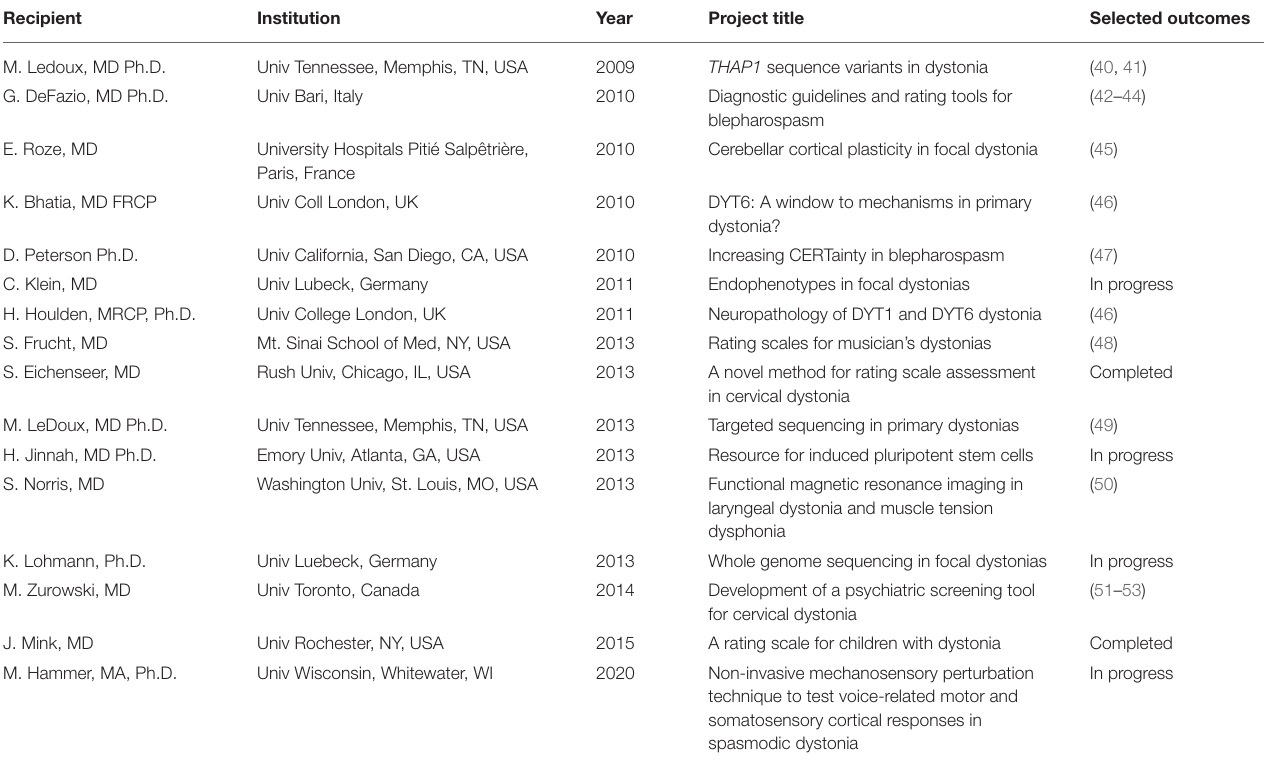
TABLE 4 | Pilot projects funded by the Dystonia